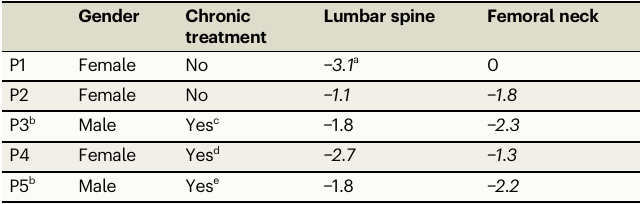
Table 1 | Abnormal bone mineral density values in WS patients Gender Chronic Lumbar treatment